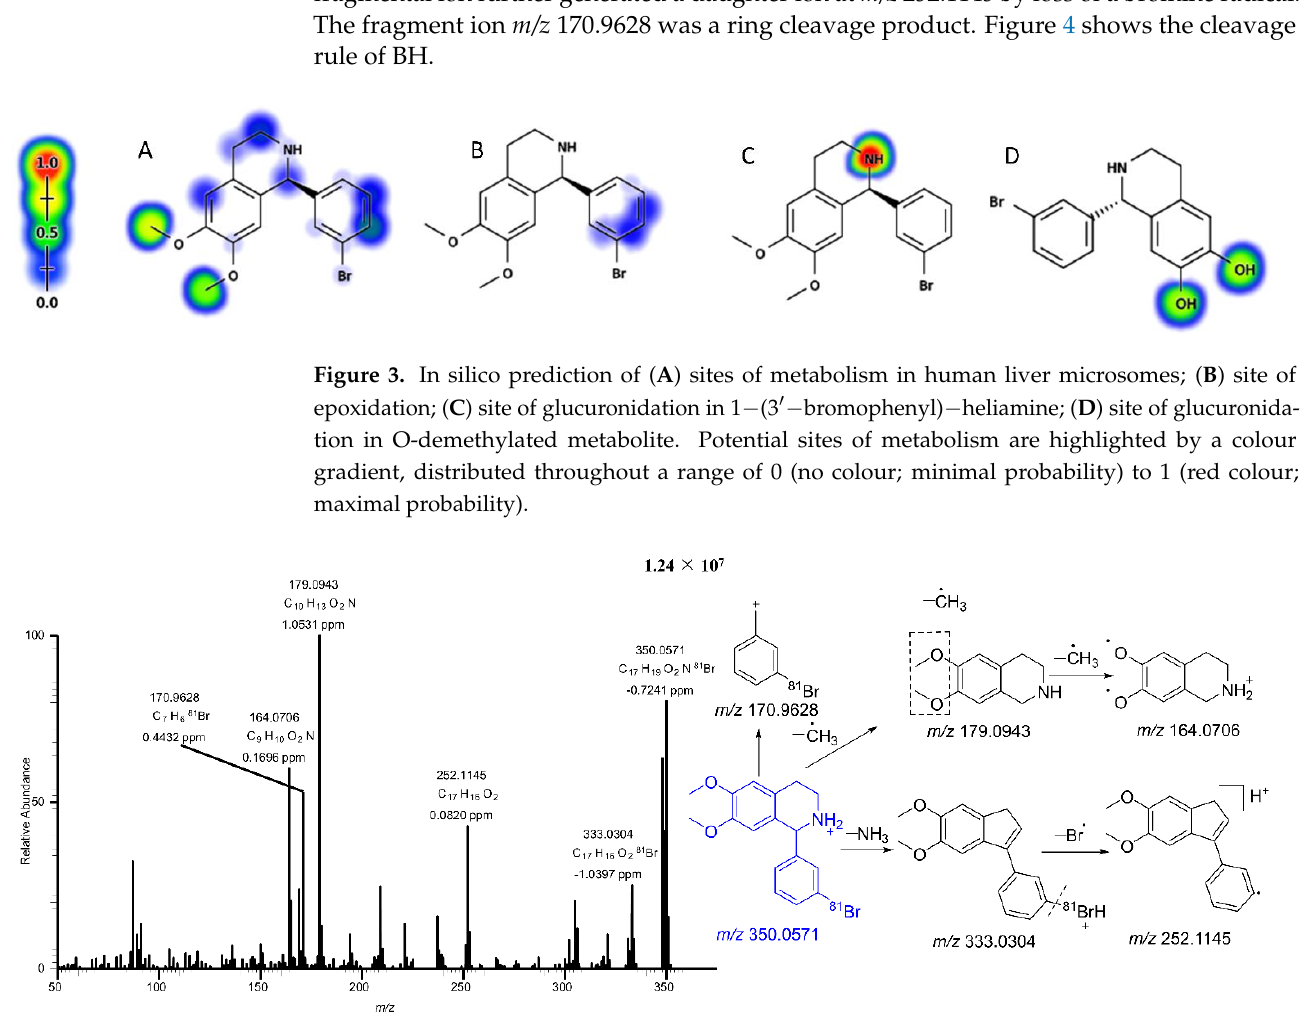
Figure 3. In silico prediction of ( A ) sites of metabolism in human liver microsomes; ( B ) site of epox- idation; ( C ) site of glucuronidation in 1 −(3′− bromophenyl) − heliamine; ( D ) site of glucuronidation in O-demethylated metabolite. Potential sites of metabolism are highlighted by a colour gradient, dis- tributed throughout a range of 0 (no colour; minimal probability) to 1 (red colour; maximal proba- bility).